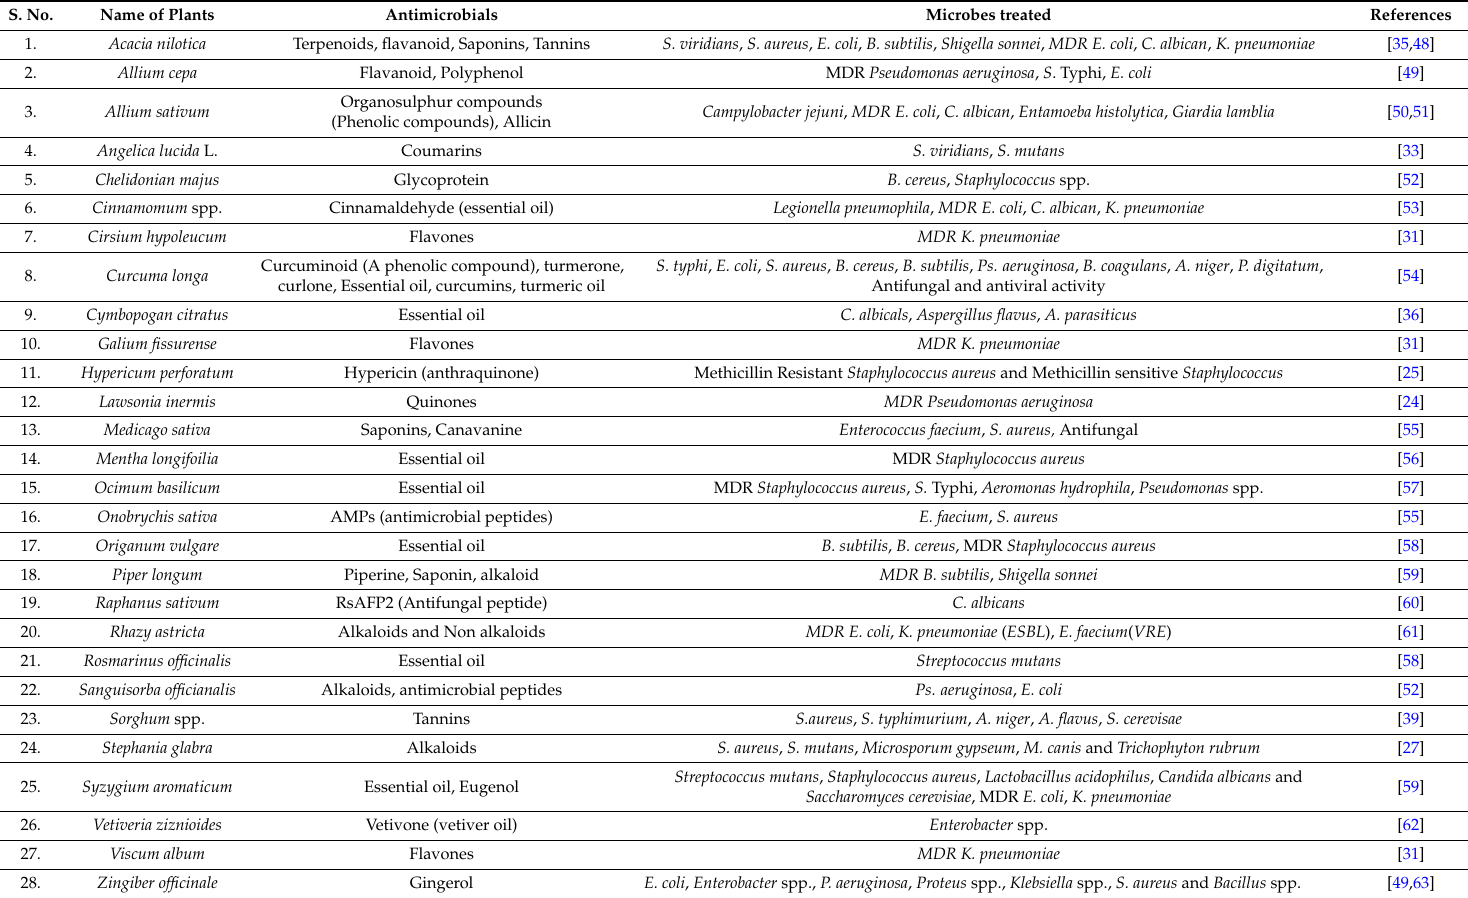
Table A1. Examples of certain plants and their antimicrobial